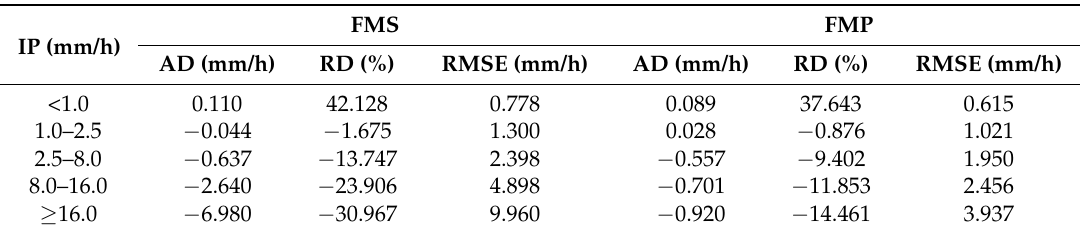
Table 2. Statistical results of fusion under different grades of precipitation between May and September from 2005 to 2010. IP, intensity of